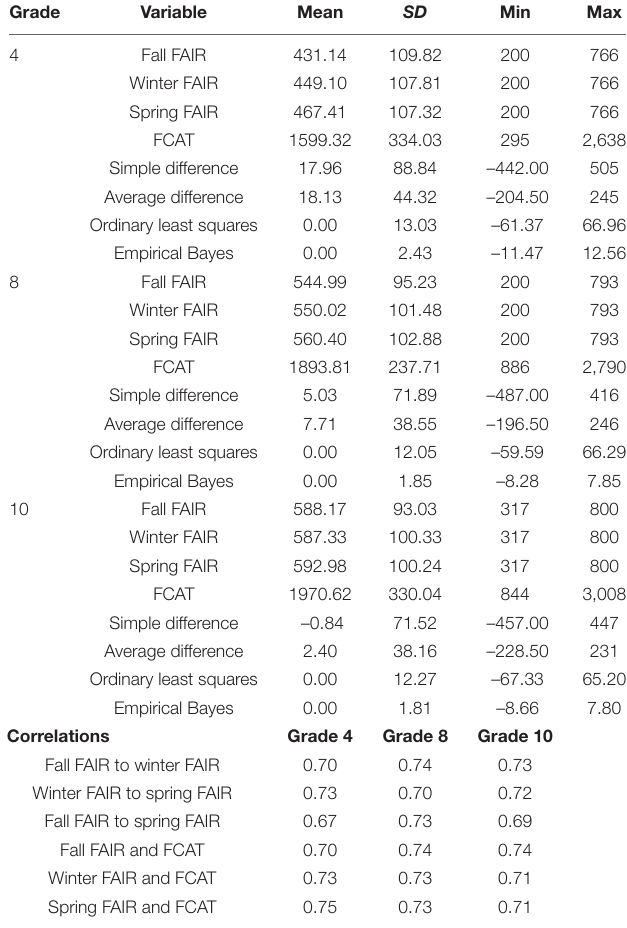
TABLE 1 | Descriptive statistics by grade level and correlations among